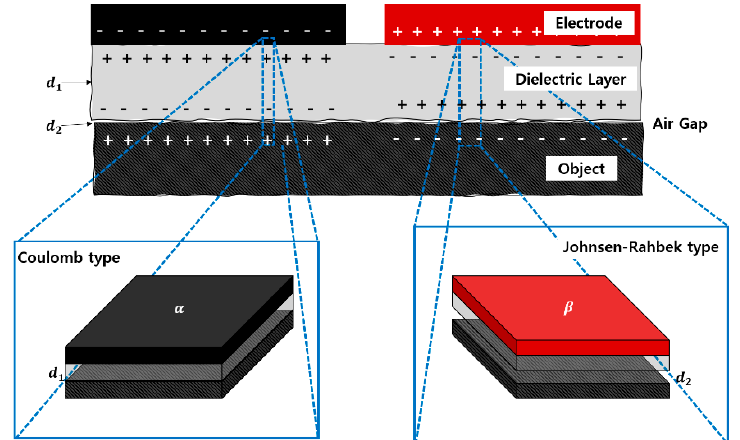
Figure 4. Electrostatic induction between the pad and wall: the Coulomb type and the Johnsen–Rahbek type. Depending on the presence or absence of an air layer, it is divided into the Johnsen–Rahbek type and the Coulomb type.